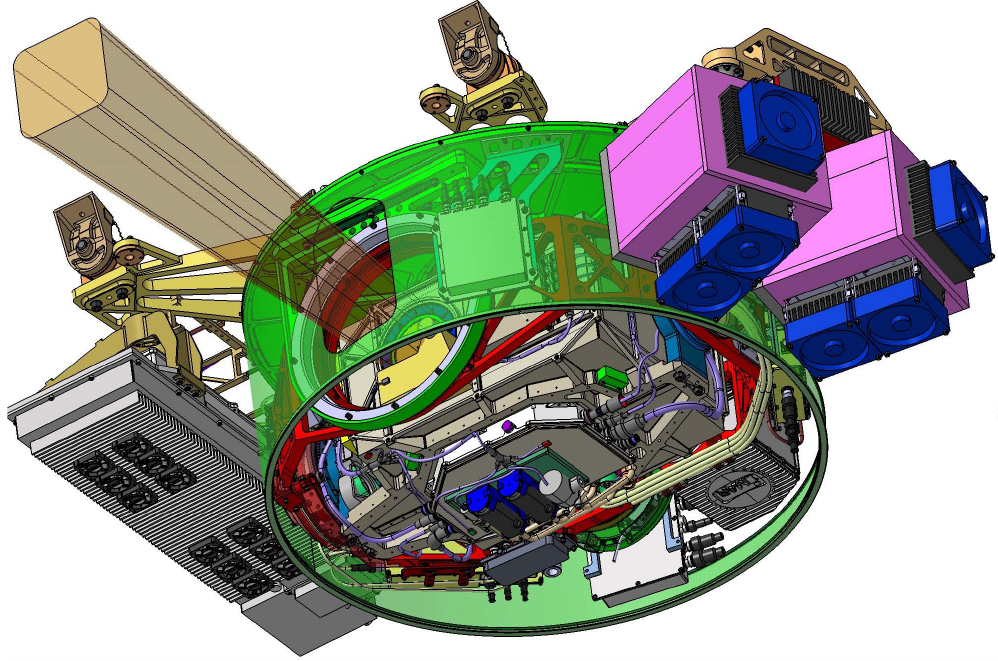
Fig. 1. Design of the GLORIA instrument. GLORIA will be housed in the belly pod of HALO and mounted on a base plate suspended from the aircraft. The picture shows a view where the carrier is omitted. The yellow beam indicates the viewing beam of the instrument. The GLORIA interferometer will be mounted in a cardanic frame for compensation of aircraft movements. The outermost, vertical axis is given by the green cylinder which also closes the belly pod to the air